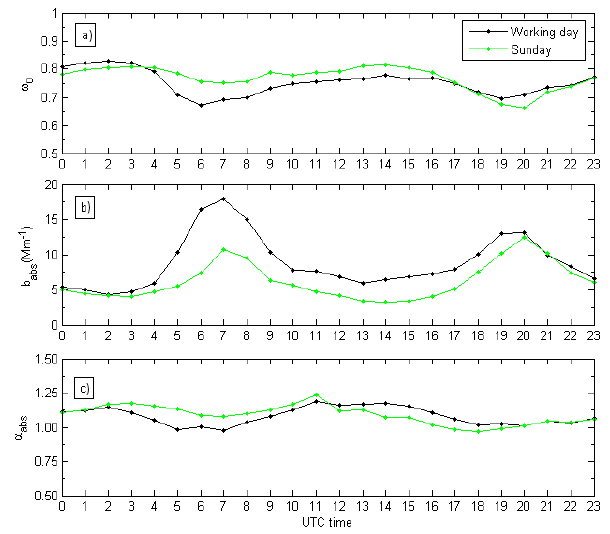
Figure 10. Comparison of average during cycles for work- days (black) and Sundays (green) of: (a) single-scattering albedo ( ω 0 , 660 ) , (b) absorption coefficient ( b abs , 660 ) , and (c) α abs